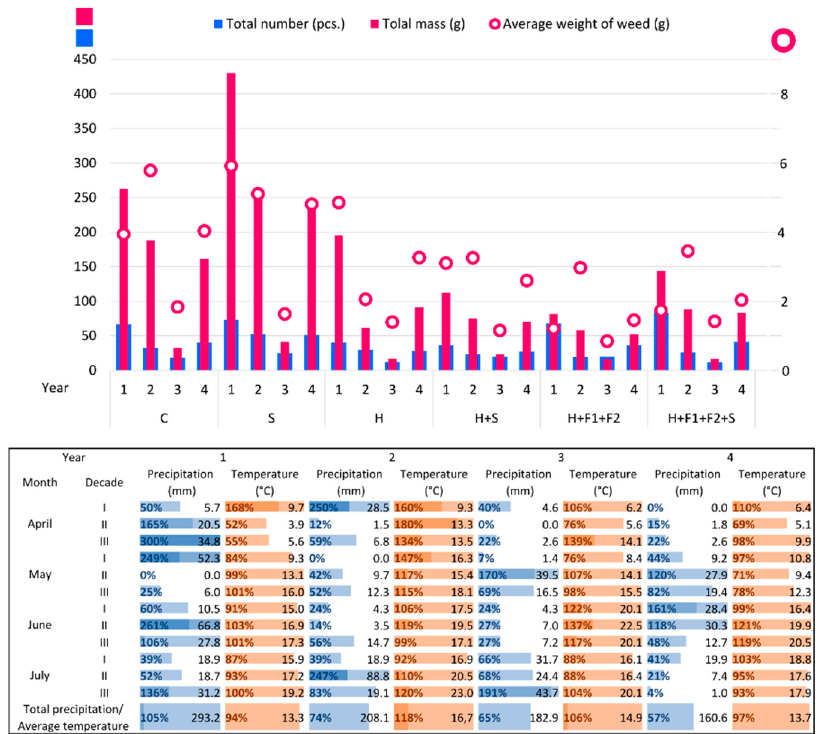
Figure 4. Total weed infestation in wheat tillage and climatic conditions: temperatures (°C) and precipitation (mm) of northeastern Poland (1—2017; 2—2018; 3—2019; 4—2020). Percentage values are related to the mean from the last decade (values below 100% indicate temperature/precipitation decrease relative to the last 10 years). C—Control; S—biostimulator; H—herbicide; F1—fungicide 1; F2—fungicide